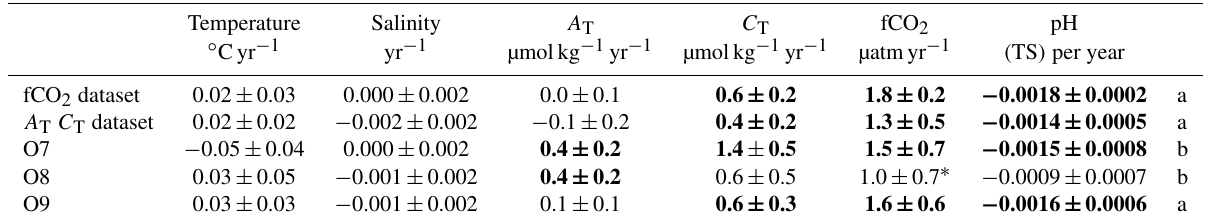
Table 2. Trends (per year) evaluated in the HNLC part of PFZ, from the fCO 2 surface dataset, the A T and C T surface dataset and the A T and C T data in the mixed layer at each station (O7–O9), estimated between (a) 1998 and 2019 or (b) 1998 and 2017. The significant trends (Student’s t test) are represented in bold (at 95%) or with a star (at 90%).